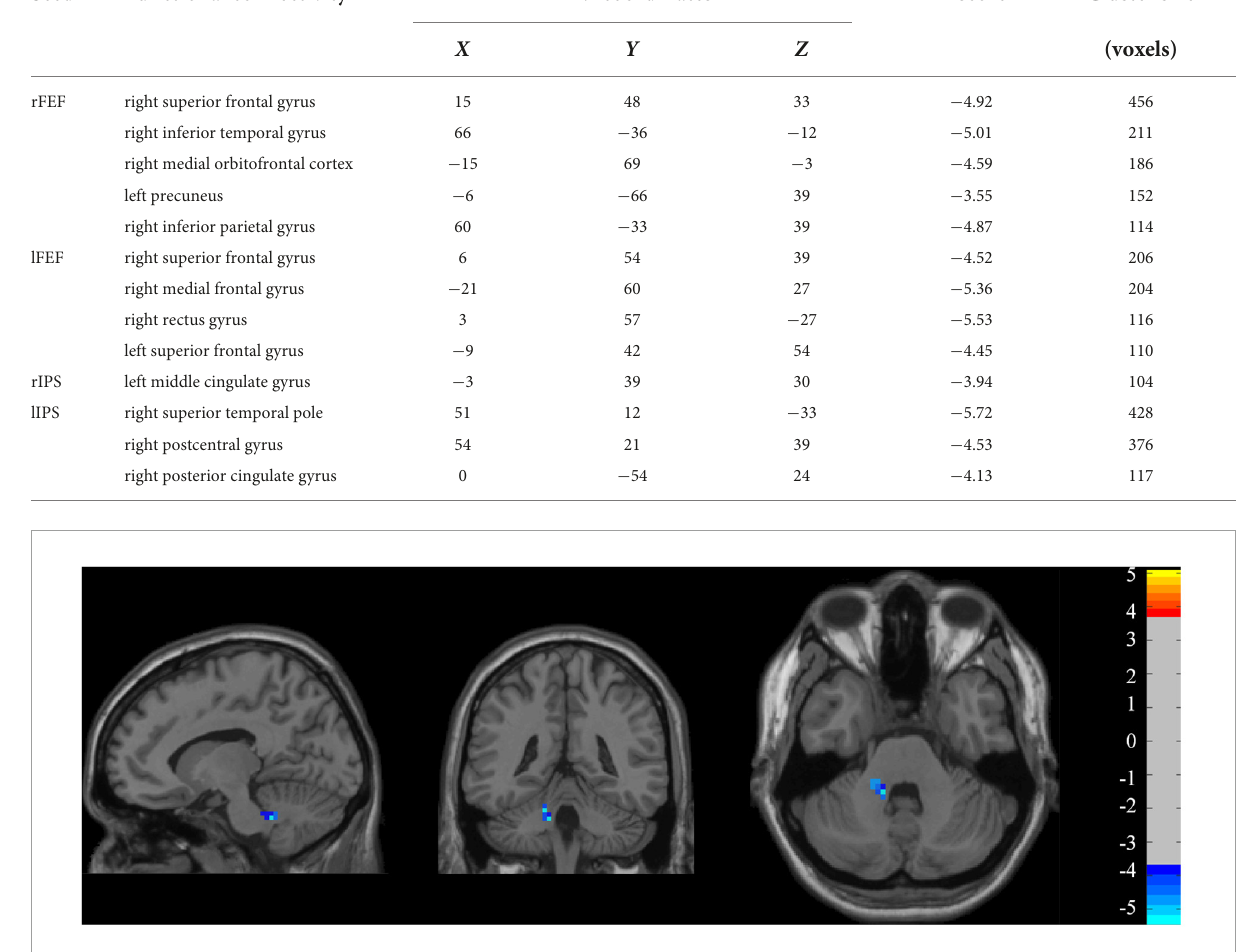
FIGURE5 ALFF maps. ALFF maps show two-sample t -tests comparing persistent VSN with rapid recovery VSN(P-R) ( p <